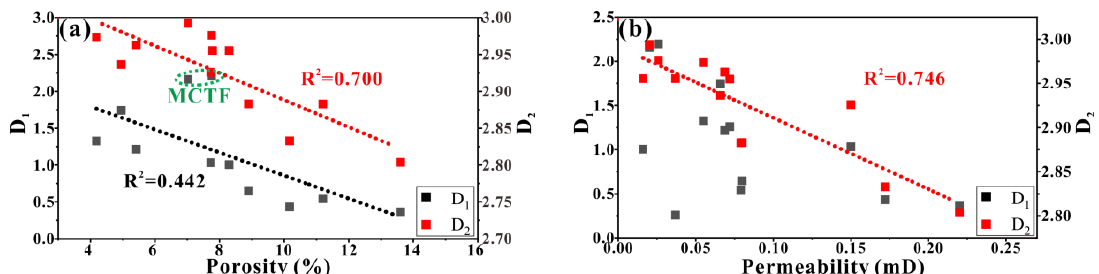
Figure 14. Relationships between the fractal dimensions and petrophysical properties. ( a ) Total porosity vs. D 1 and D 2 ; ( b ) total permeability vs. D 1 and D 2 .